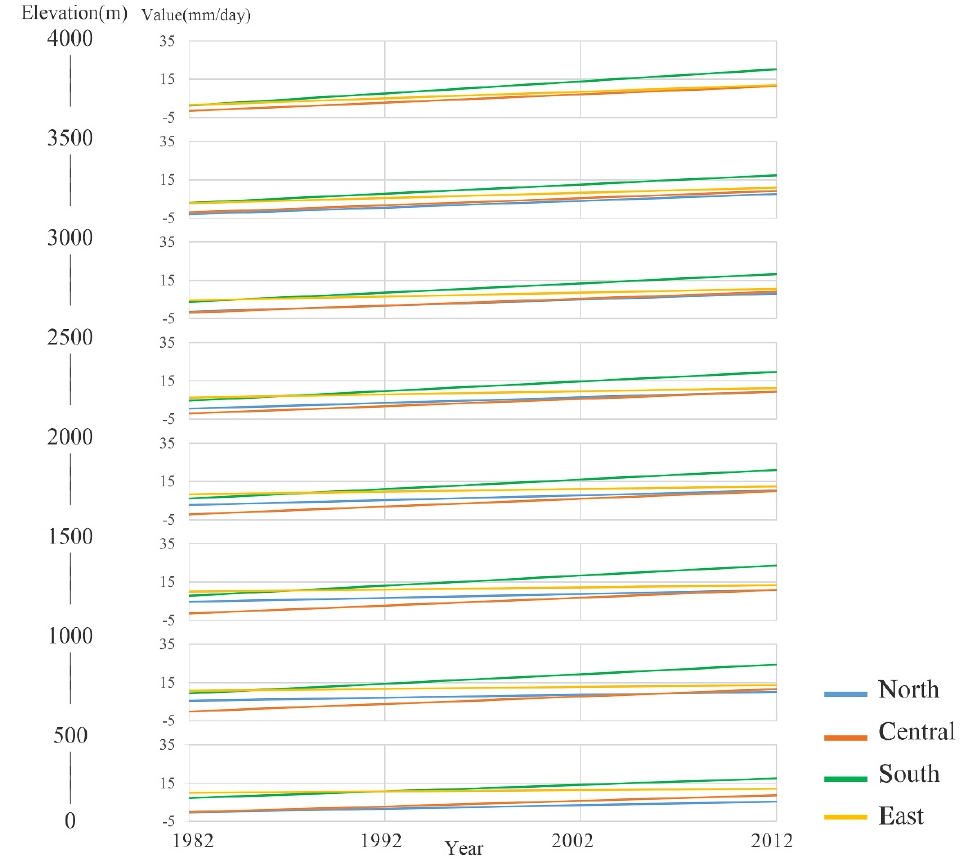
Figure 14. Regional and seasonal comparison for the dry and wet seasons.